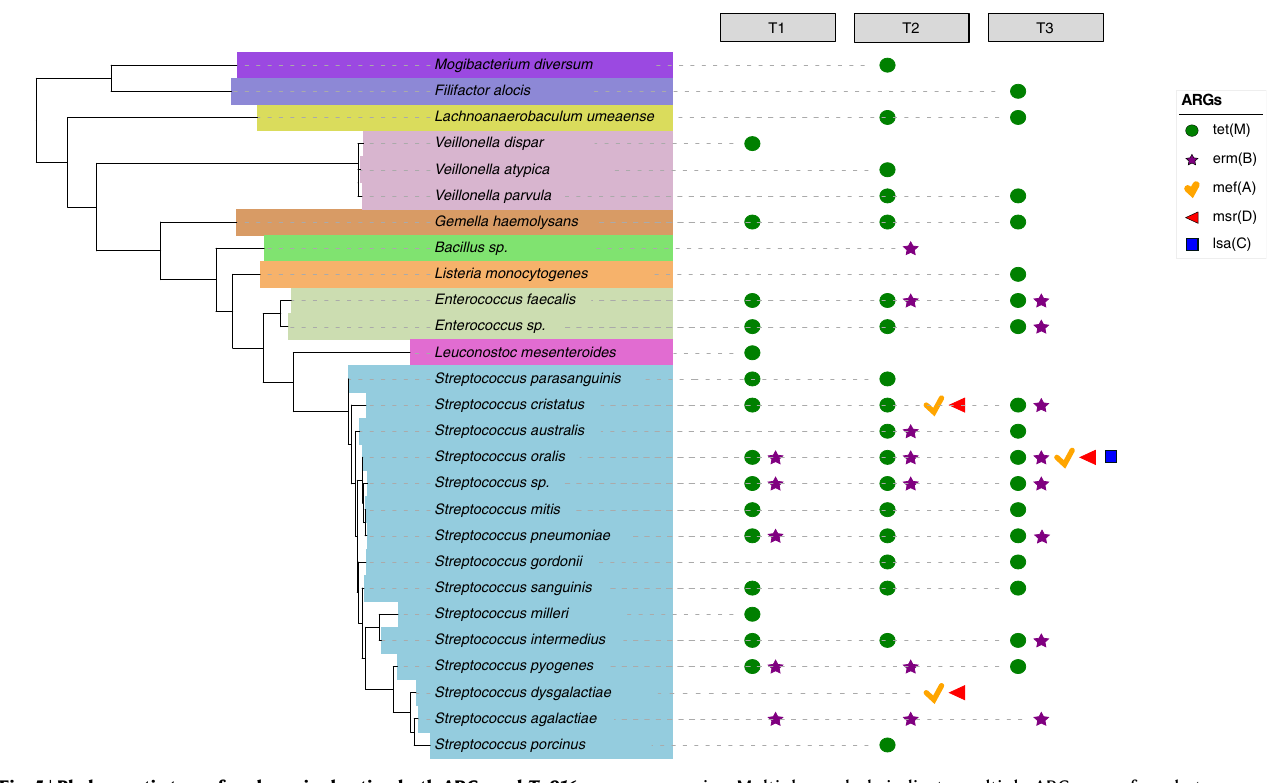
species. Multiple symbols indicate multiple ARGs were found at an individual contig level with Tn916 . The tree was extracted from the tree shown in Fig.